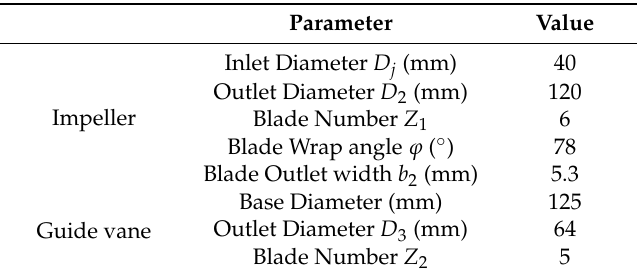
Table 1. Parameters for the model jet centrifugal pump.